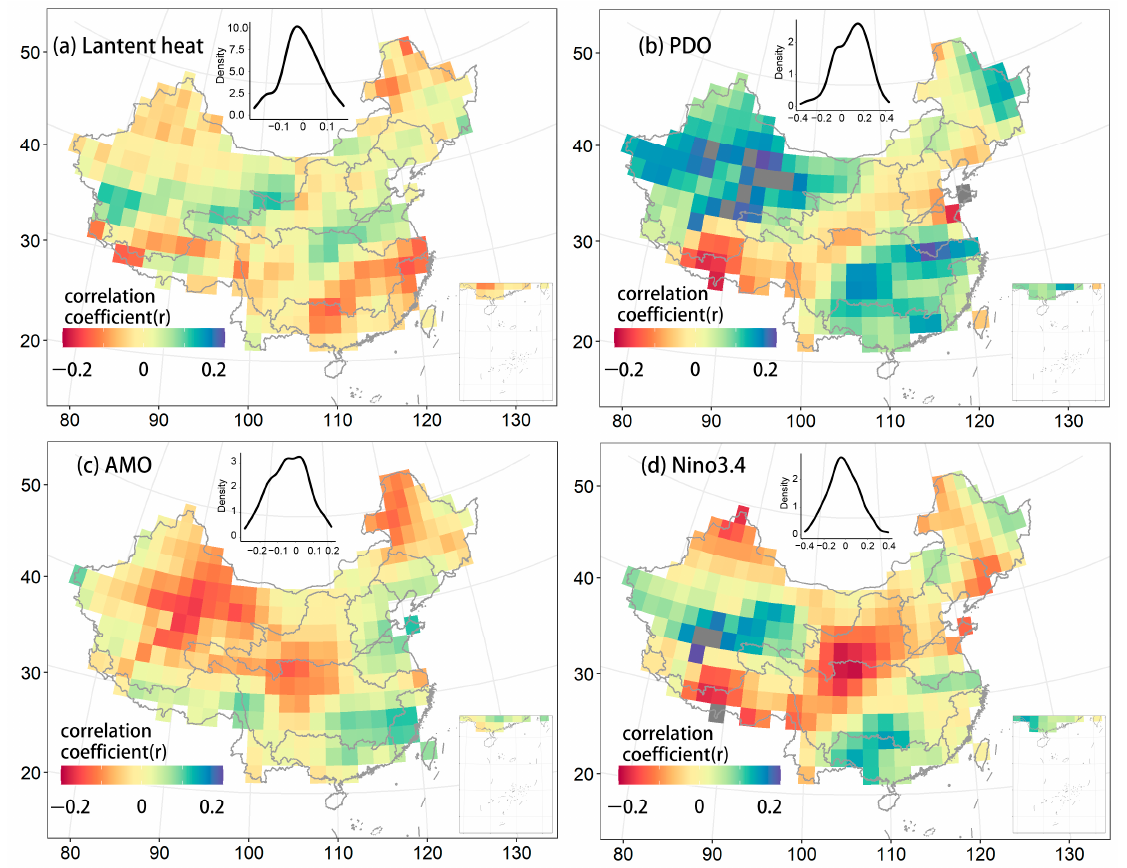
Figure 6. Spatial distribution of SPEI-12 response to LHF, PDO, AMO and Nino3.4.